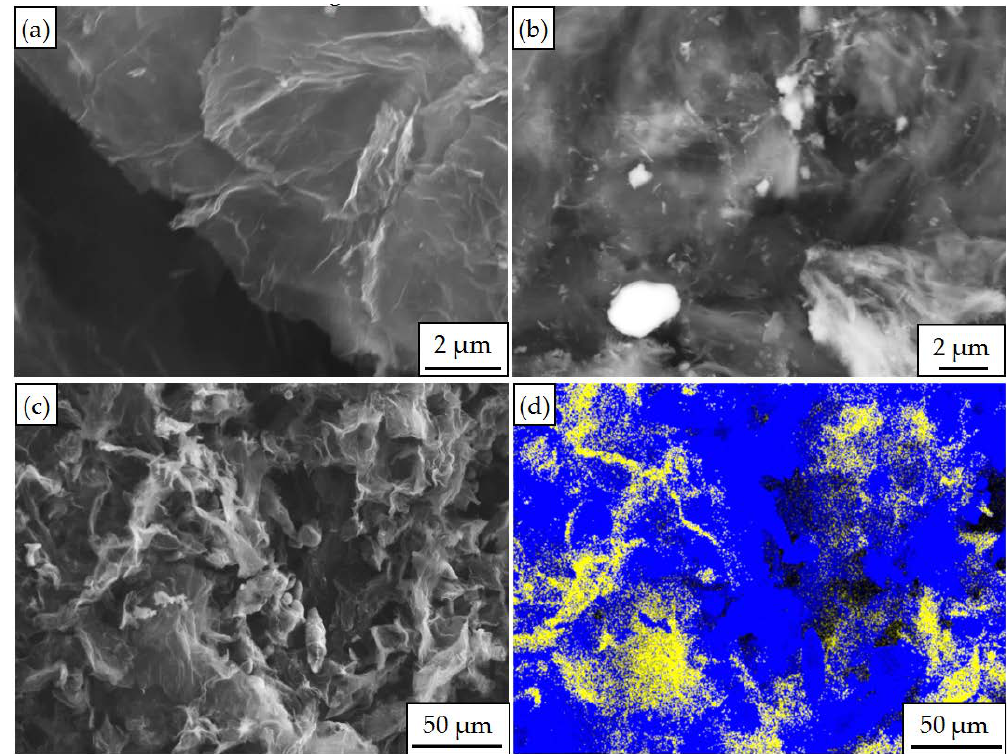
Figure 1. Scanning electron microscopy (SEM) image and energy dispersive spectrometer (EDS) analysis of Graphene/aluminum composites with different reaction times: ( a ) Graphene/aluminum composites prepared with reaction time of 1 h; ( b ) Graphene/aluminum composites prepared with reaction time of 1.5 h; ( c ) Low-magnification SEM image of composite prepared with reaction time of